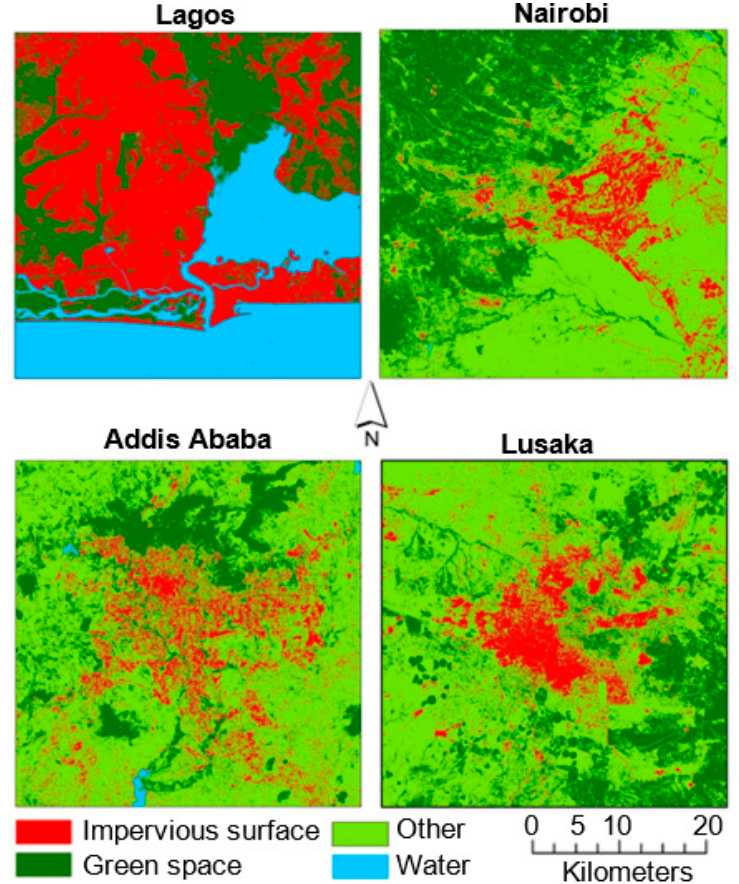
Figure 4. Land cover maps for the study areas: Lagos, Nairobi, Addis Ababa and Lusaka.